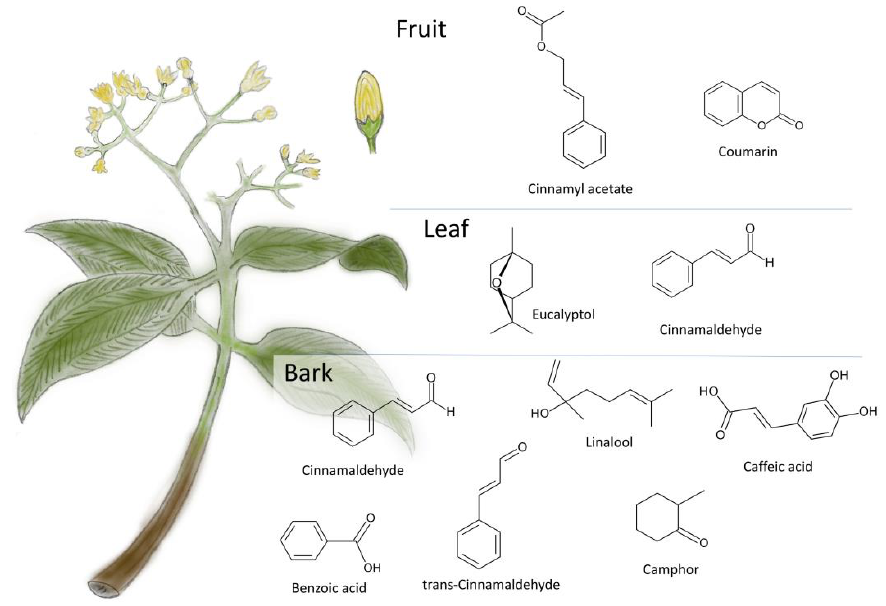
Figure 1. Selected bioactive compounds of cinnamon in different parts of the plant [5,6].